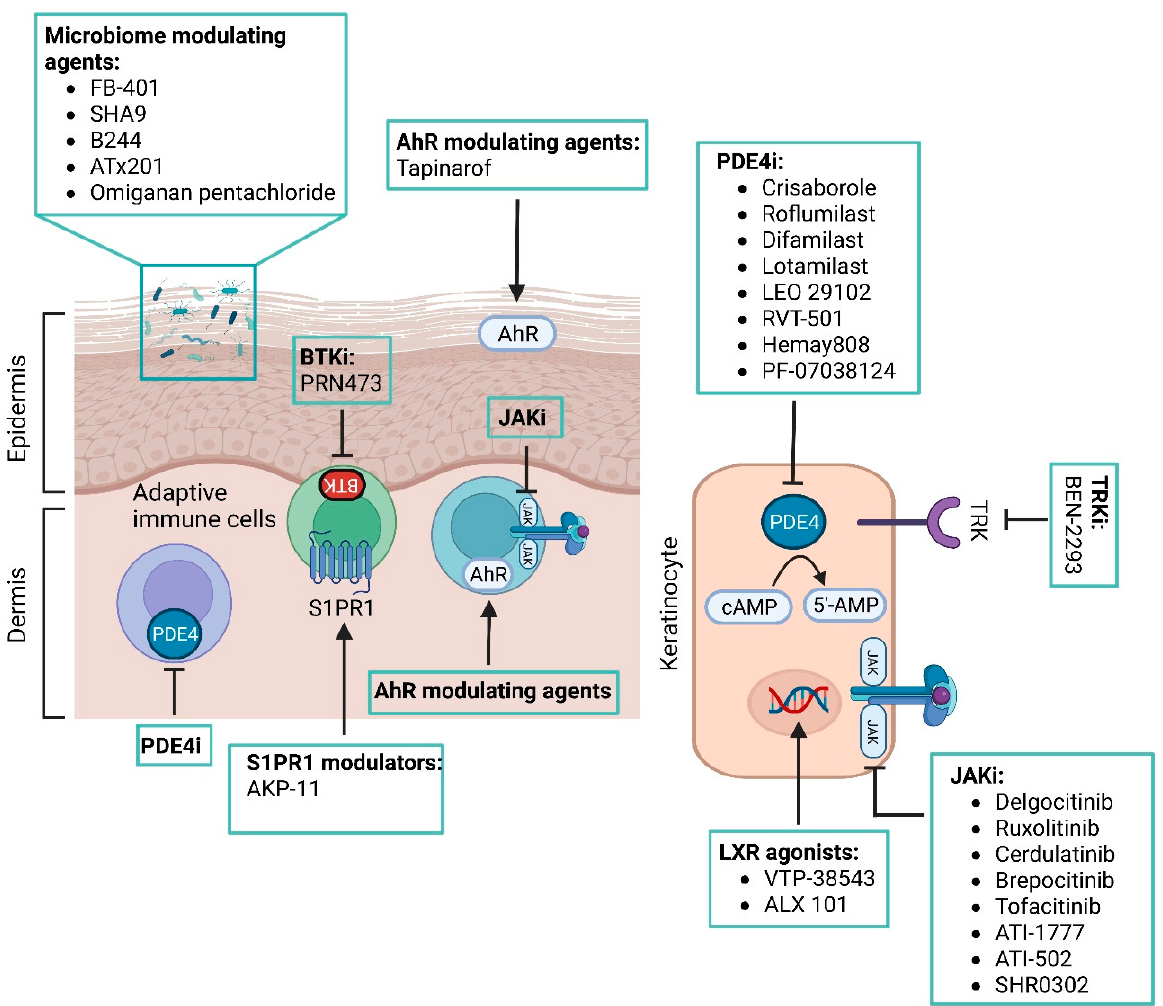
Figure 2. Outline of topical therapeutic strategies and relevant cellular targets in atopic dermatitis.